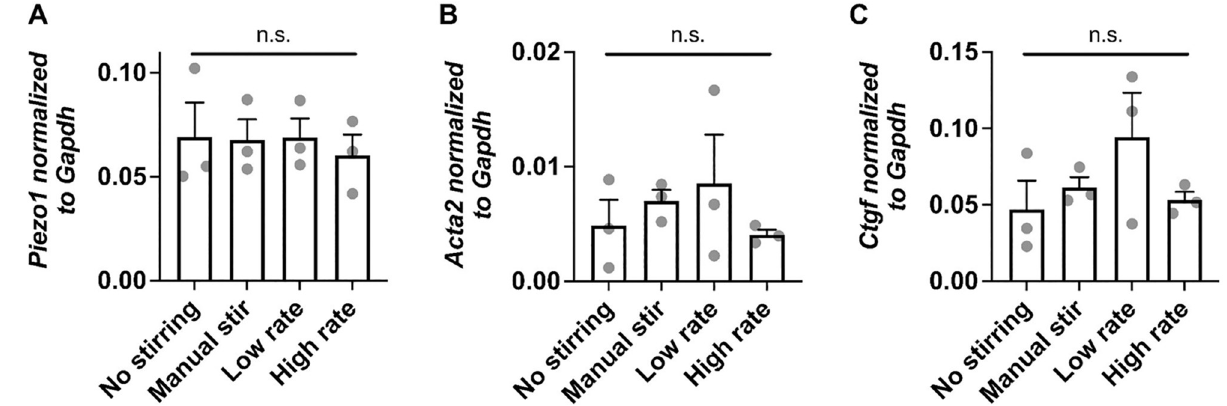
Fig 4. Agitation does not alter the expression of mechanosensitive genes at a shorter timescale. Gene expression analysis of (A) Piezo1 , (B) Acta2 , (C) Ctgf in MSCs from different tested conditions after 120 min. n = 3 independent experiments, each performed in three replicates. Error bars represent standard